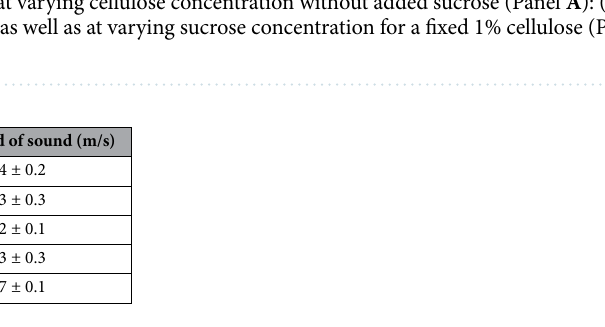
Table 3. Measured speed of sound versus concentration of cellulose employed in the phantom fabrication.